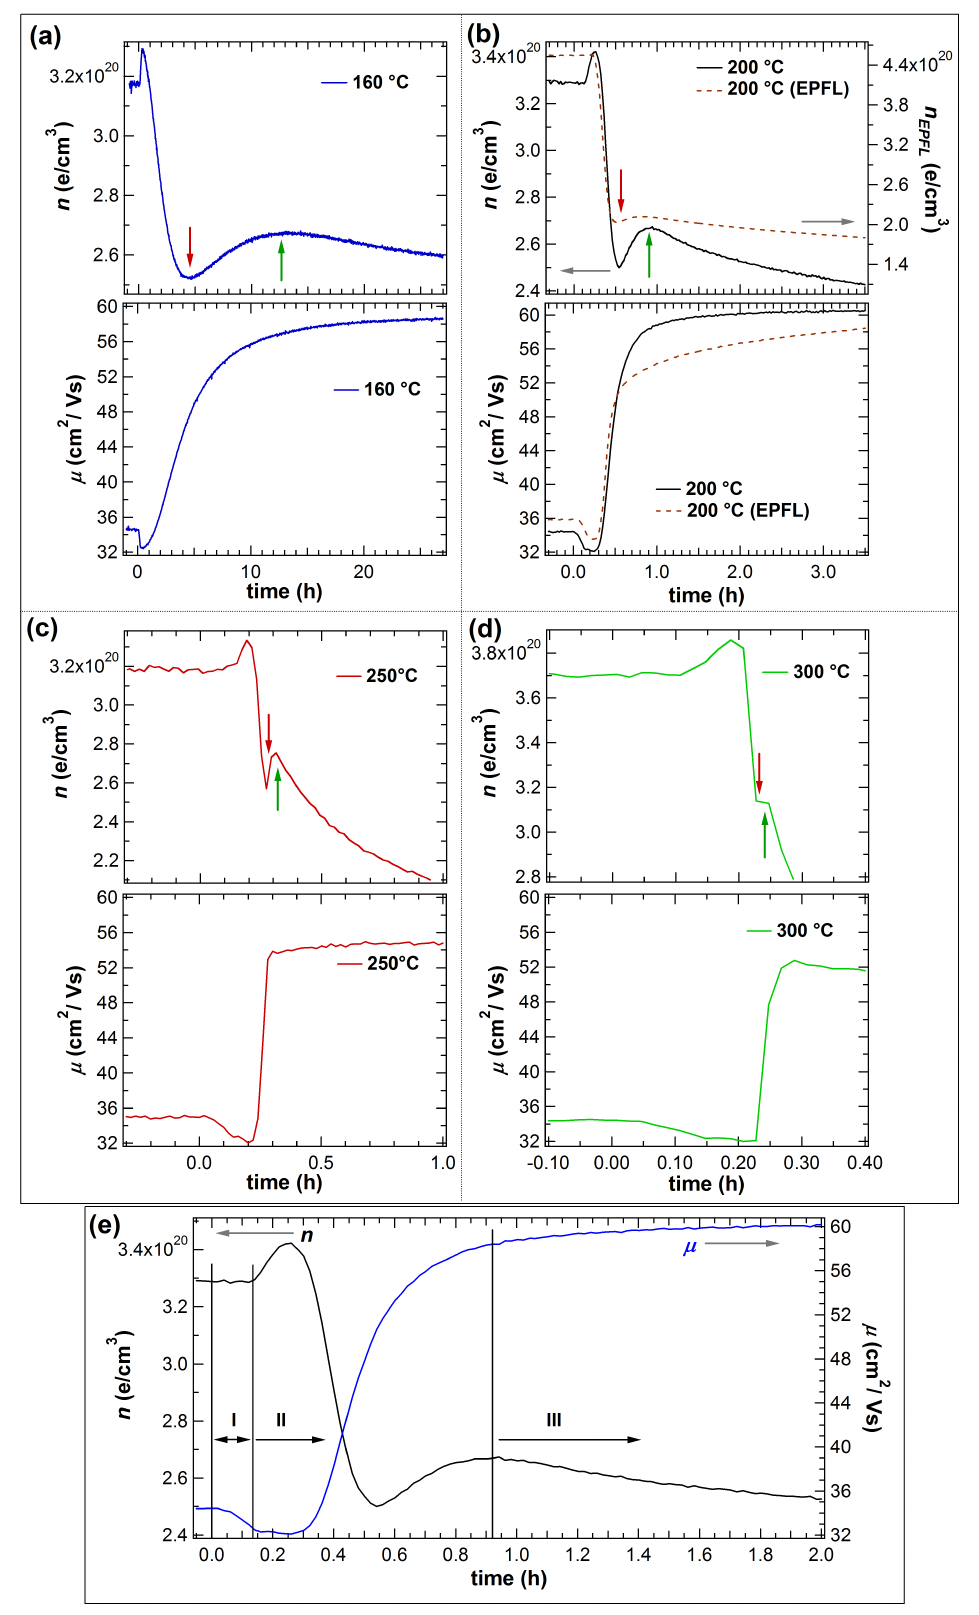
Figure 6. Zoom-in on the beginning of in situ Hall effect measurements during vacuum annealing at different temperatures of as-deposited films with p (H ( a – d ). Dependence of n and µ on time for the film annealed at 200 ◦ C shown on a different timescale ( e ). The start of furnace heating is set to 0 h, with a rate of 20 K/min to reach the target